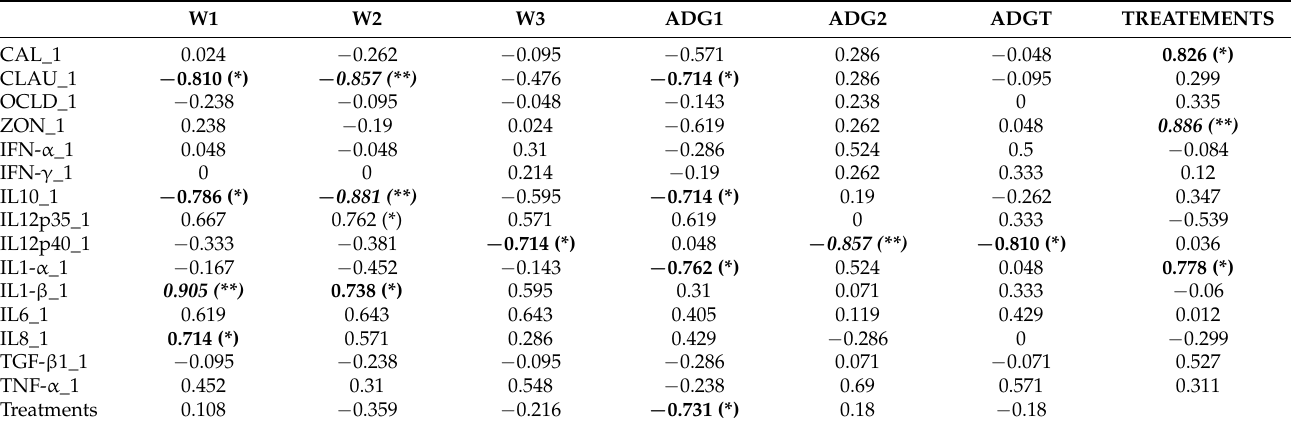
Table 8. Correlations among biomarkers in second fecal sampling and physical performances related to growth and